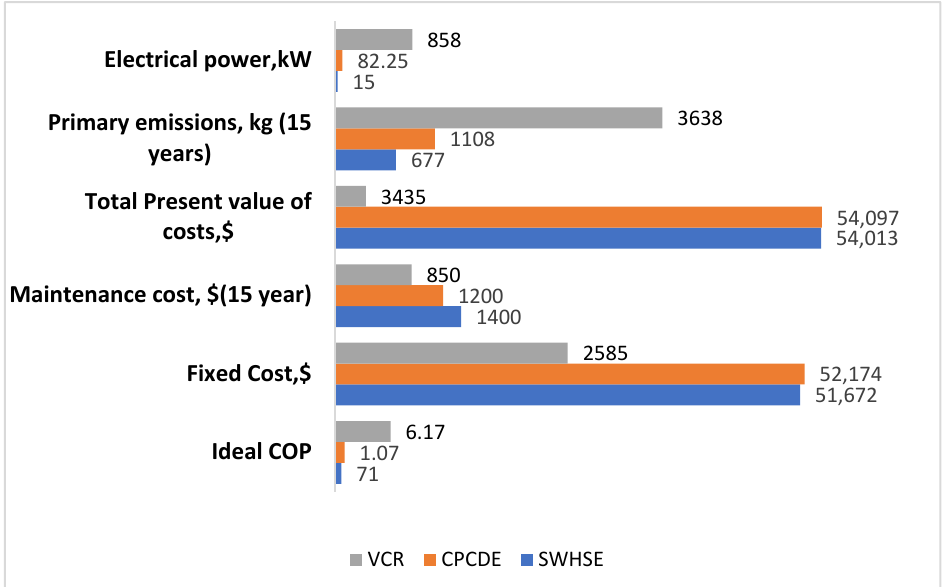
Figure 9. Comparison of performance of the best ranking single effect solar method (SWHSE), double effect solar method (CPCDE) and vapor compression method(VCR) for Niger (Bsh).